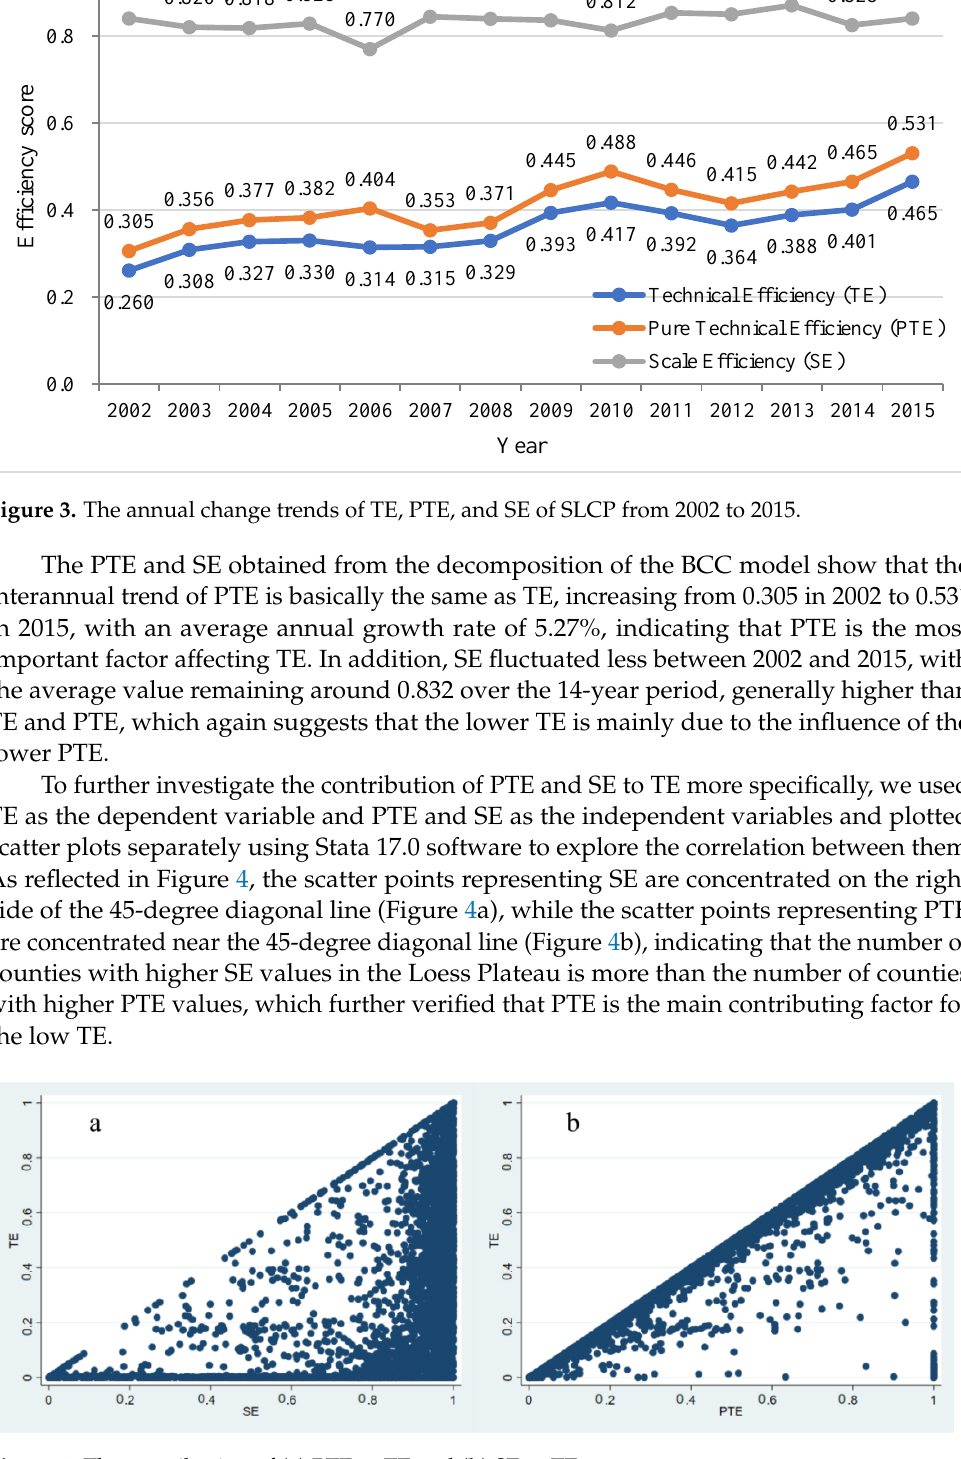
Figure 4. The contribution of ( a ) PTE to TE and ( b ) SE to